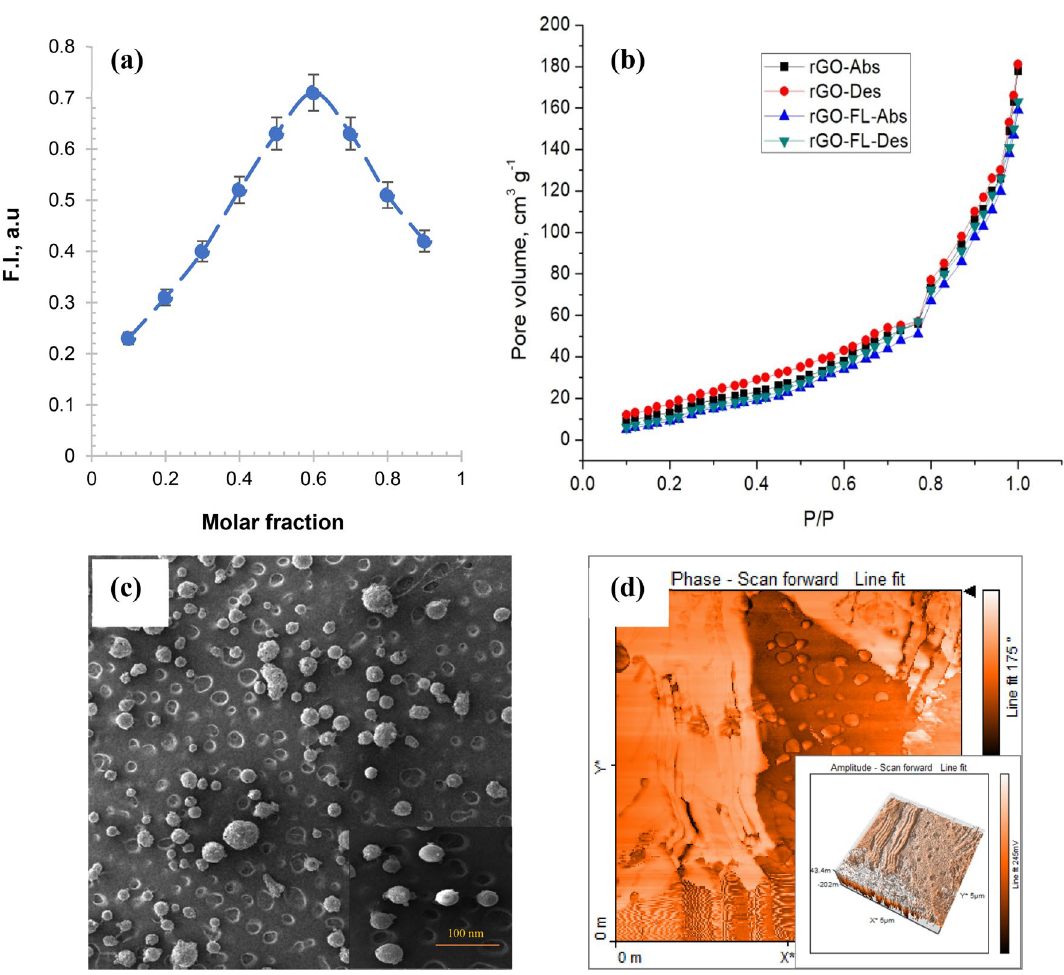
Figure 2. ( a ) Job’s plot for optimum stoichiometric complex formation between rGO and FL. Job’s plot provides qualitative and quantitative details about the stoichiometry of association between reduced graphene oxide (rGO) and ligand (Fluorescenc) to form rGO–FL complex contain 0.7 mL of 1 mmol rGO and 1 mmol of fluorescein. The complex formation between rGO and FL was studied using fluorescence emission at 510